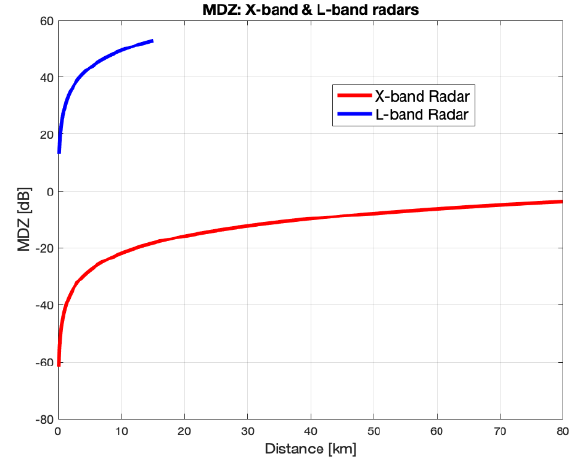
Figure 2. Minimum detectable signal (MDZ) computed for X-band ( red line ) and L-band ( blue line ) radars, known as the operational radar characteristics.